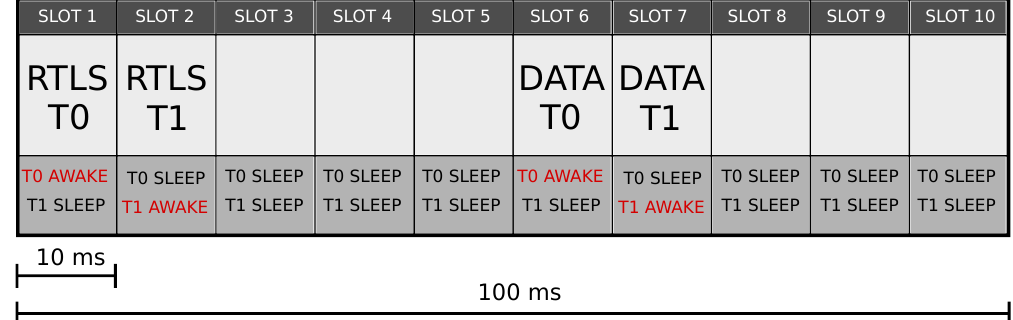
Figure 3. Superframe structure with the division in 10 time